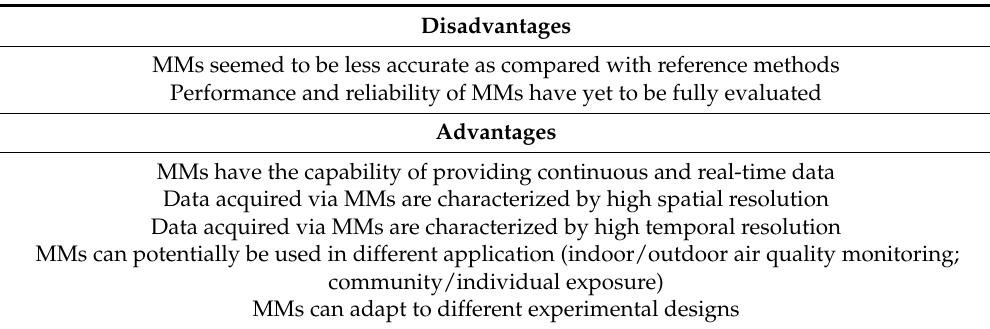
Table 5. Disadvantages and advantages related to the use of